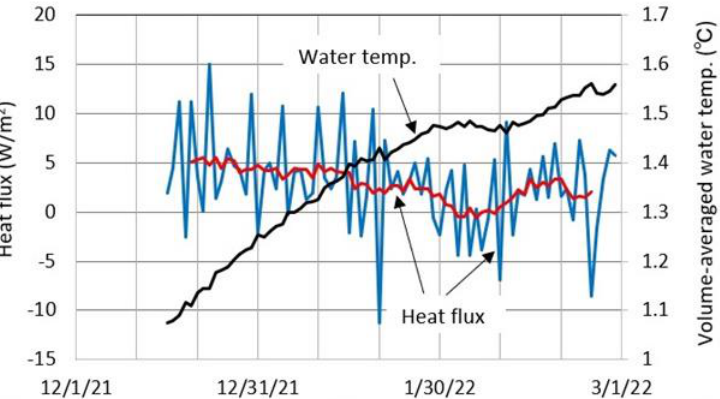
Figure 16. Temporal variations in daily (blue line) or 10-day moving average (red line) heat flux (W/m 2 ) at the bottom and the cumulative volume-averaged water temperature (black line) in the heated layer for 15 December 2021 – 28 February 2022.